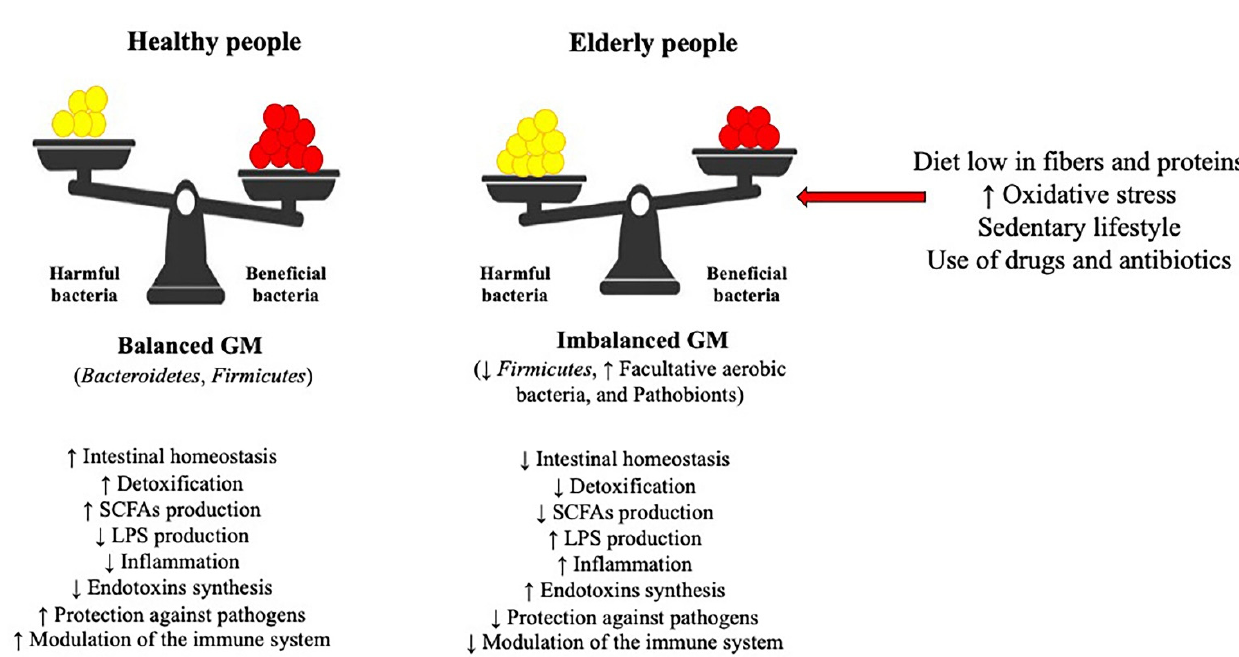
Figure 1. Effects of an altered gut microbiota (GM) in elderly people. A diet low in fibers and proteins, an increase in oxidative stress, a sedentary lifestyle, and an intake of drugs and antibiotics lead to an alteration of the intestinal microbiota, with a reduced production of SCFAs and an increase in LPS, resulting in gut inflammation and development of metabolic diseases. Abbreviations: SCFAs: shot-chain fatty acids; LPS: lipopolysaccharides.